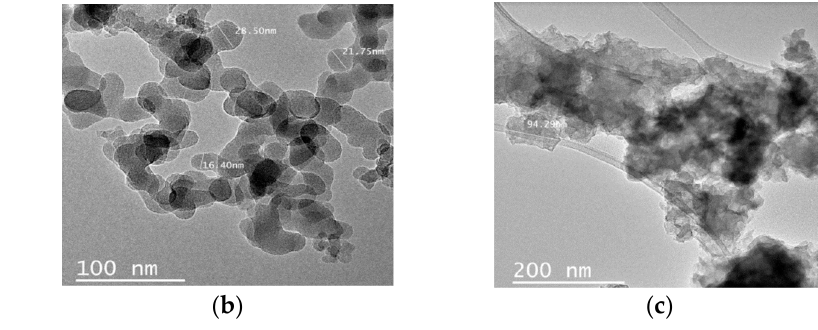
Figure 2. HR-TEM micrographs of ( a ) Si07, ( b ) Si200 and ( c ) Al nanoparticles. Table 3. Estimated mean particle size (d p-50 ), surface area (S BET ), total acidity and the isoelectric point of the Si07, Si200 and Al after surface modification processes.